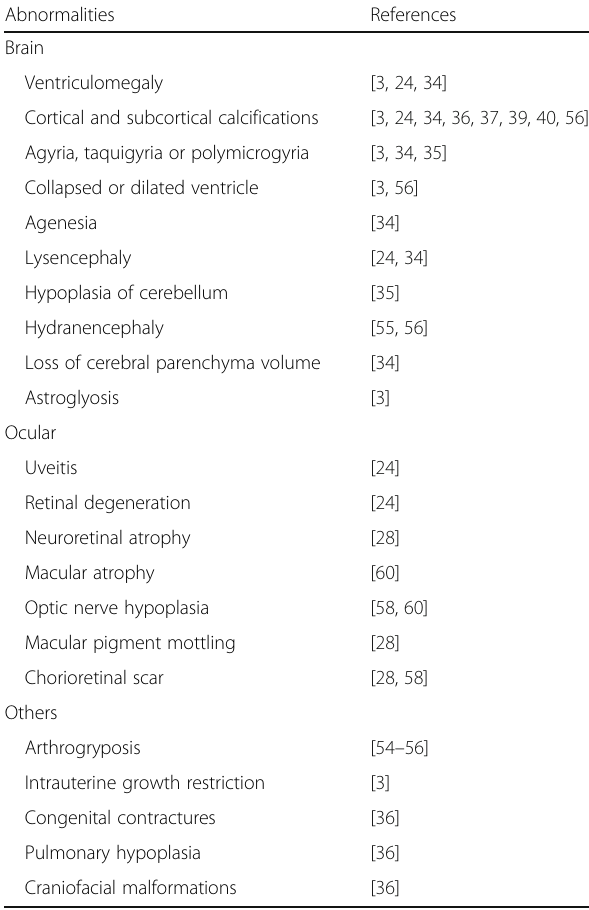
Table 1 Clinical aspects of newborns from infected mothers with Zika virus during pregnancy